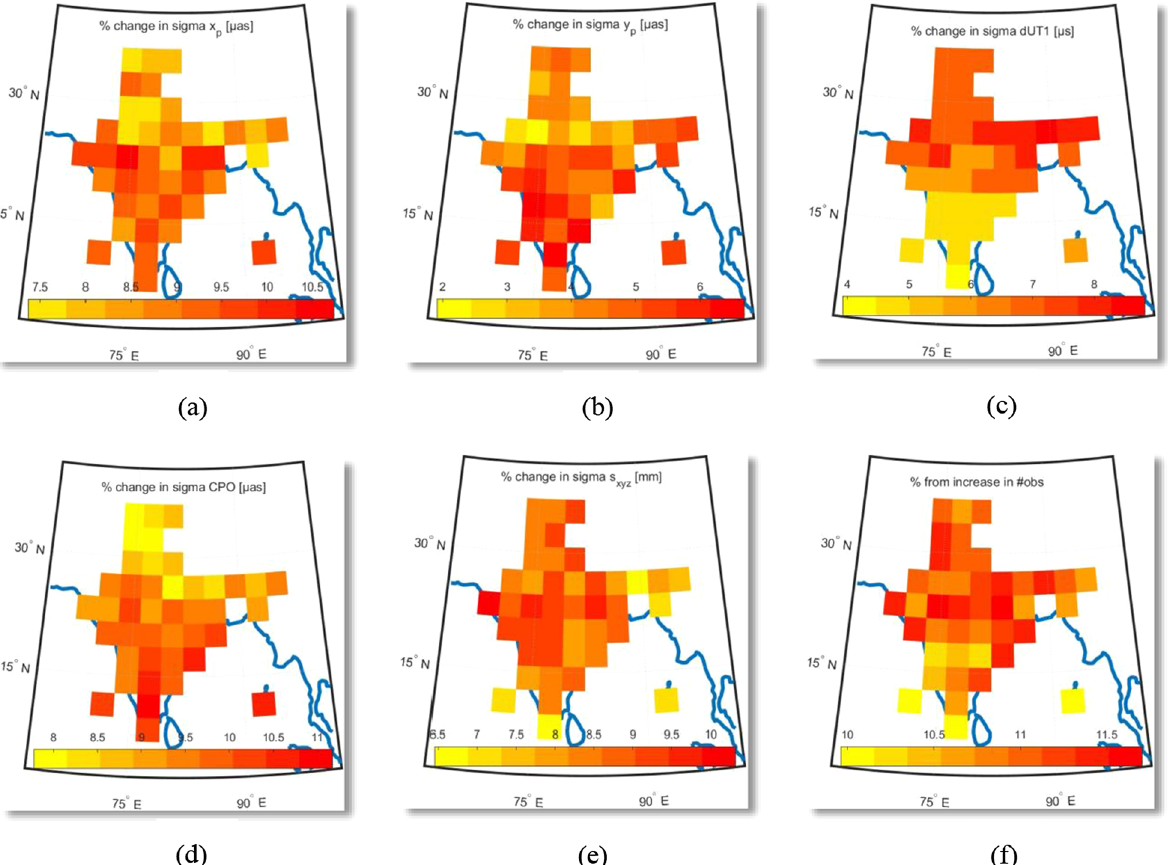
Fig. 5 a – e Percentage improvement in the mean formal error (sigma) of geodetic parameters in the first scenario; f expected improvement percentage from the increase in